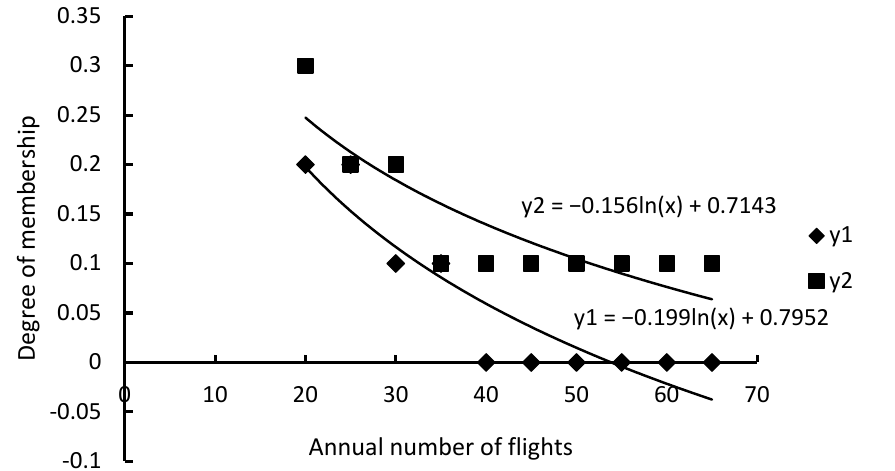
Figure A29. Single factor evaluation for the index of annual number of flights (more than 20 times).